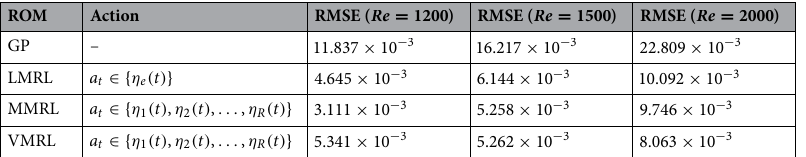
Table 1. ℓ 2 norm for the deviation of the velocity with respect to its true projection value for t ∈ [ 0, 1 ] . We note that both snapshot data generation for POD analysis and RL training are performed at Re = 1000